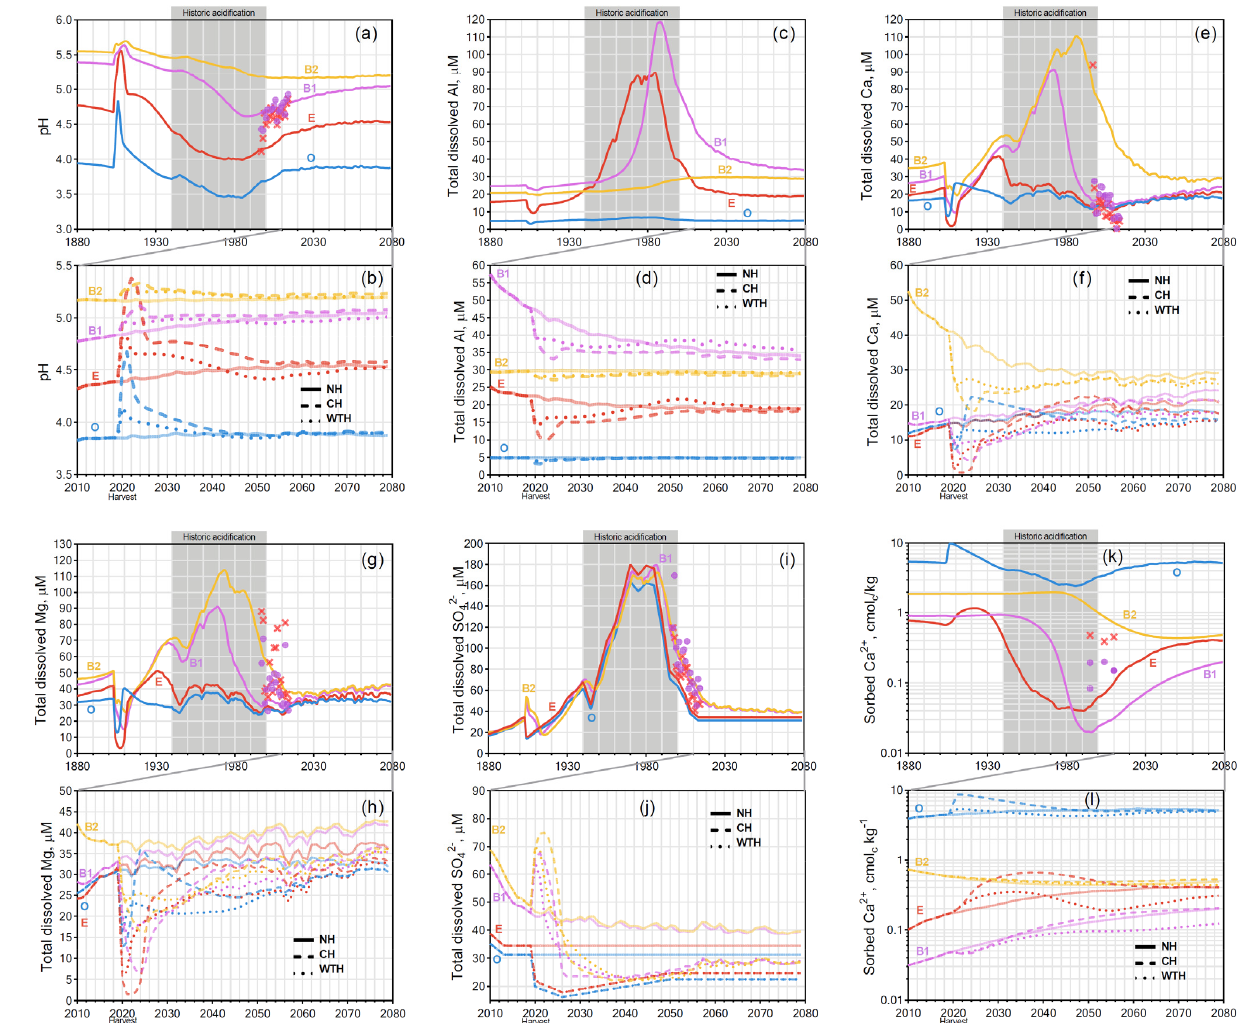
− (i, j) ; and sorbed 4